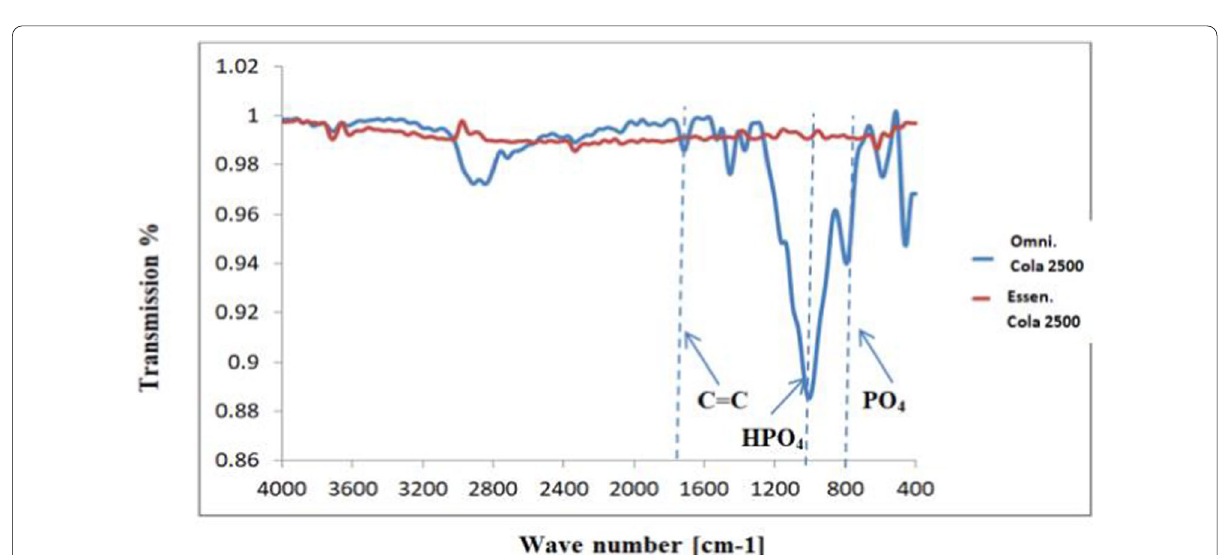
Fig. 10 FTIR spectra representing the chemical structure of Omnichroma Cola 2500 and Essentia Cola